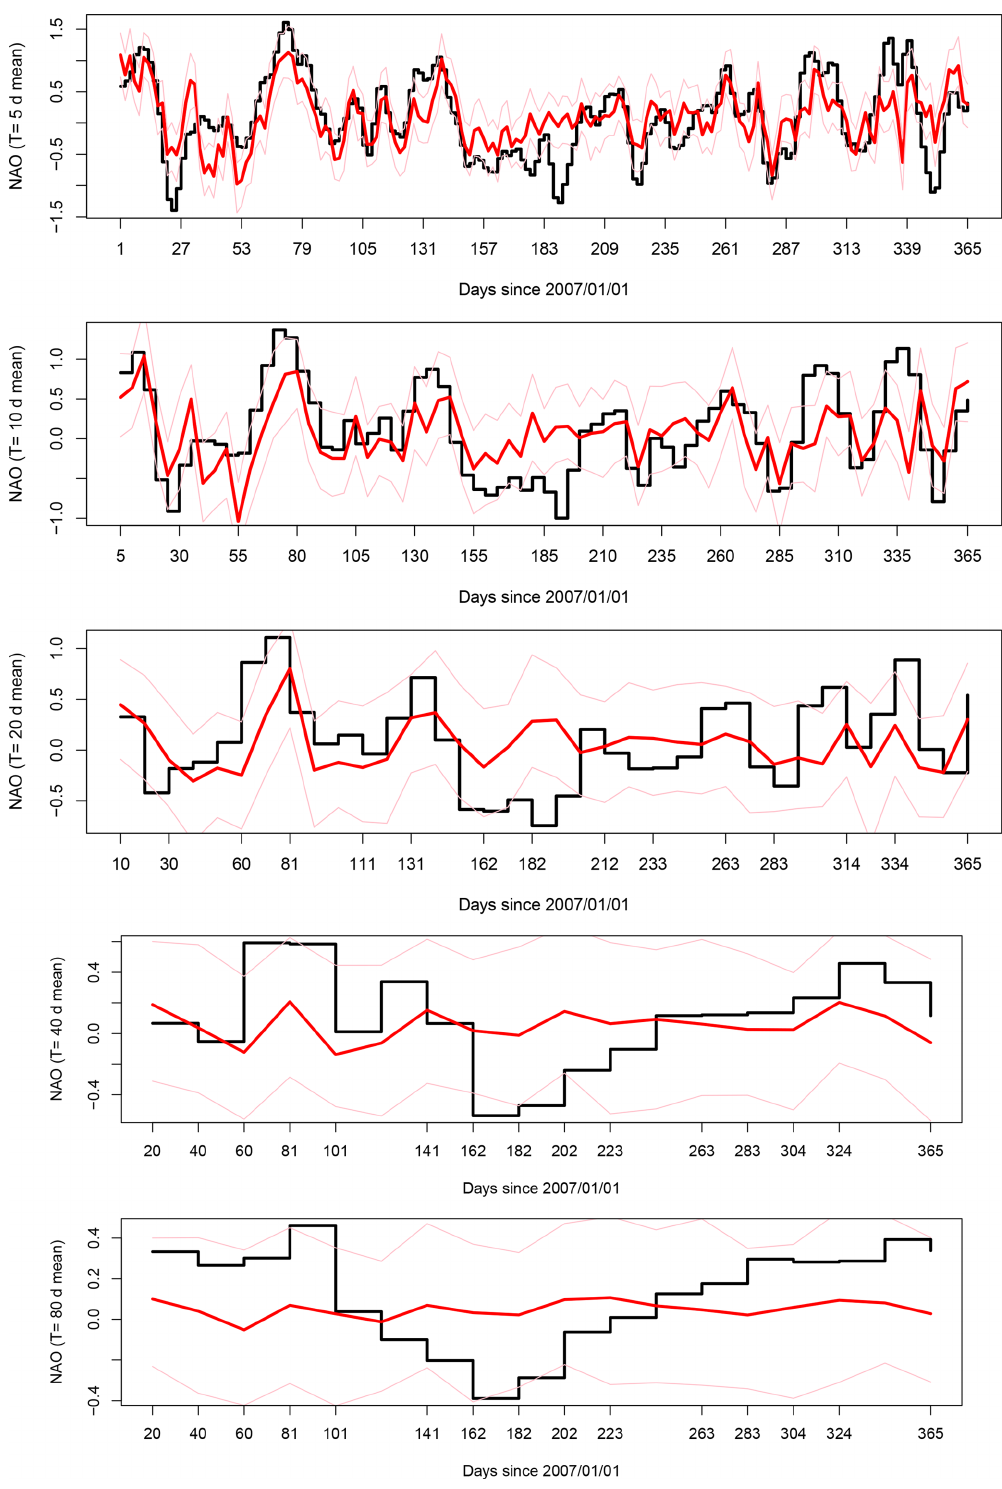
Figure 6. Multivariate autoregressive (mAR1) model time series of ensemble forecasts for 2007, for lead times T ∈ { 5 , 10 , 20 , 40 , 80 } days. Black lines represent observed averages over lead times T . Red lines represent the median of 100 simulations; pink lines represent the 5th and 95th quantiles of the 100-member